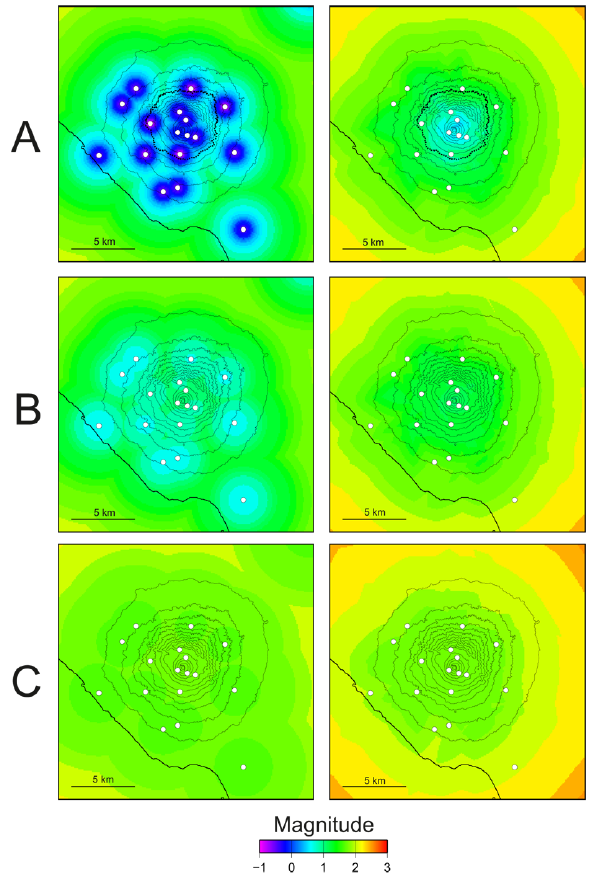
Figure 3. Left: plot of the theoretical magnitude detection threshold for the seismic stations of the Vesuvius network at 3 different depths: 500 m a.s.l. (A); 1500 m b.s.l. (B) and 5000 m b.s.l. (C). Right: theo- retical magnitude of completeness calculated at the 3 different depths as in the left